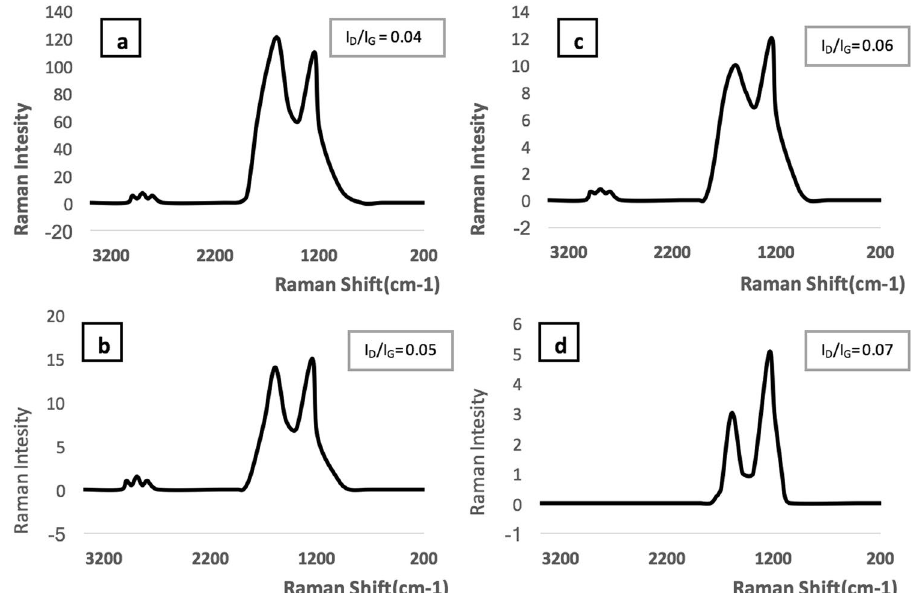
Figure 3. Raman spectra of ( a ) GO, ( b ) r-GO-31, ( c ) r-GO-19, ( d ) r-GO-9 (The I D /I G ratio as abstract value for in-plane lattice